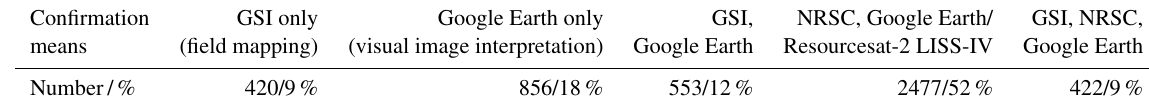
Table 3. The number of landslide confirmations by different means in Kerala.